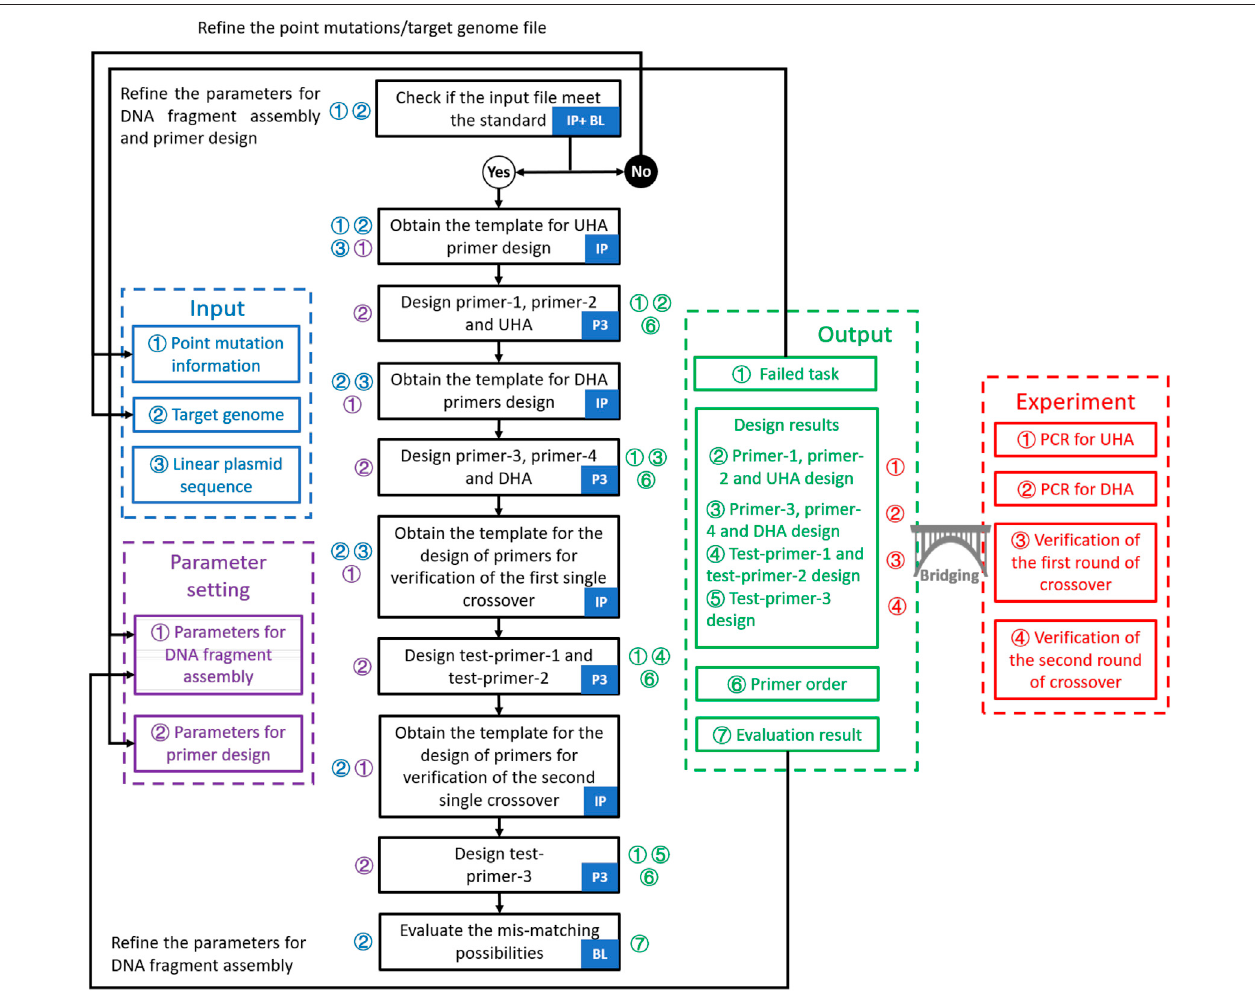
FIGURE 2 | Work fl ow for the design of point mutations in GEDpm-cg. The design of primers and homologous arms is performed by three programs: In-house program, Primer3 and BLAST. Logical judgment fl ow is divided into detailed steps which are marked with corresponding inputs (blue numbers), parameters (purple numbers) and outputs (green numbers). Moreover, output fi les linked to experiments are marked with red numbers. First, three input fi les are checked by the in-house program and BLAST. If the input fi le does not meet the standards, it should be re fi ned. Otherwise, they will be submitted to the back-end program with the parameterssetbytheuser togothrough thedesignprocess. Thedesignprocess consistsofthreemainoperations:determinationofthetemplates forprimerdesignby thein-house program,designofprimersbasedonthetemplatesbyPrimer3and evaluation ofthemis-match likelihoodofUHA/DHA byBLAST. Then,thedesignresults will be provided in four output fi les. “ Failed task ” and ‘ Evaluation result ’ canguide the user to re-optimize the parameters. “ Design results ” and ‘ Primer order ’ are used to guide the experiment. IP, In-house program; P3, Primer3; BL, BLAST; UHA, upstream homologous arm; DHA, downstream homologous arm; PCR, polymerase chain